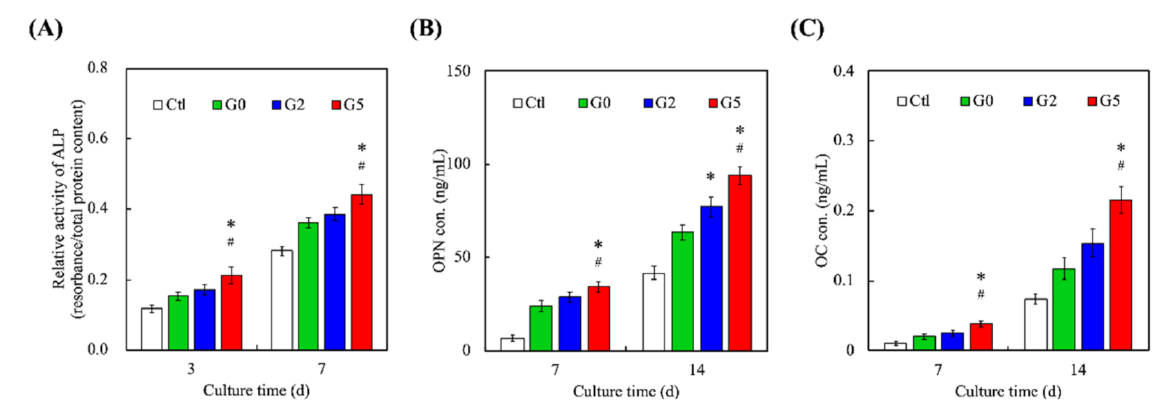
Figure 8. Osteogenic-related differentiation markers of ( A ) ALP activity ( B ) OPN, and ( C ) OC expression of hDPSCs cultured on different scaffolds for different time-points. * indicates a significant difference ( p < 0.05) from G0. # indicates a significant difference ( p < 0.05) from G2. Data presented as mean ± SEM, n = 6 for each group.